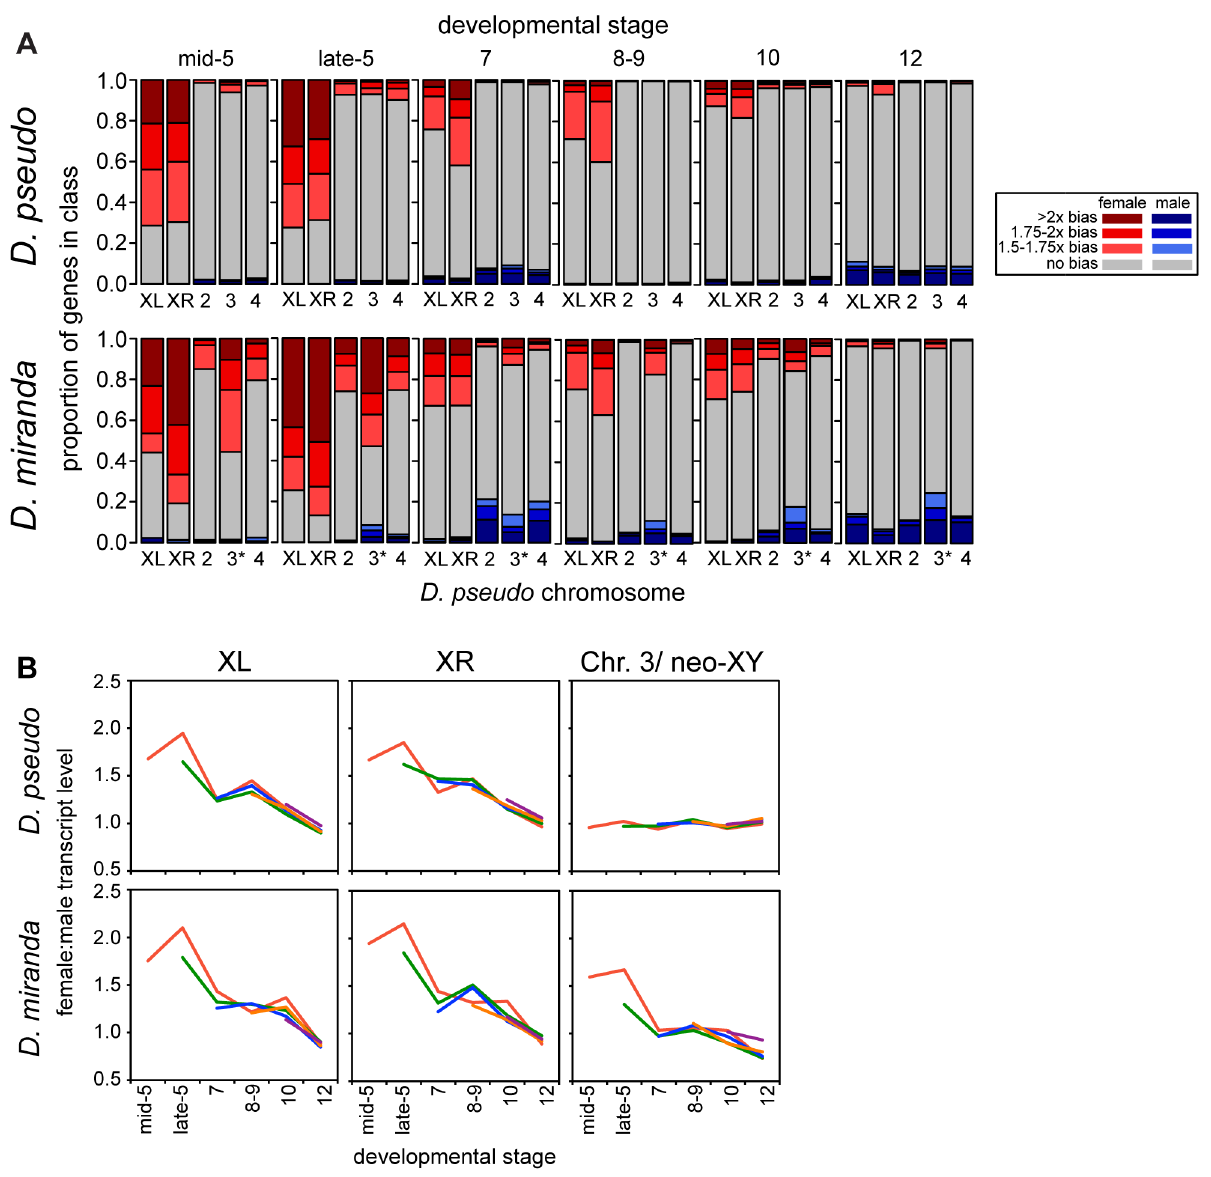
Figure 3. Onset of dosage compensation in D.pseudoobscura and D.miranda , on a genome-wide scale. A) Barcharts show proportions of zygotic genes in each sex-bias class, determined by the allele-specific zygotic definition, of female biased (shades of red), male biased (blue), and unbiased genes (grey), for each chromosome. D. pseudoobscura chromosome names were used, so the * is a reminder that this chromosome is the neo-XY in D. miranda , for this chromosome, reads from both the neo-X and neo-Y are included. As roughly half of the genes on the neo-Y are still producing transcript, this chromosome is currently a mix of genes that are hemizygous in males and those that have two functional copies, and perhaps unsurprisingly then, looks less female-biased than the ancestral X chromosomes. See Tables S5 and S7 for statistical analyses of the data in this figure. B) Female to male transcript ratio for genes grouped by when substantial zygotic transcription is first observed (see Methods for definition, lines are drawn originating in the stage where zygotic transcription is observed and indicated by color), show that the pattern of sex bias in expression is relatively constant within a stage, regardless of when genes become zygotically active.